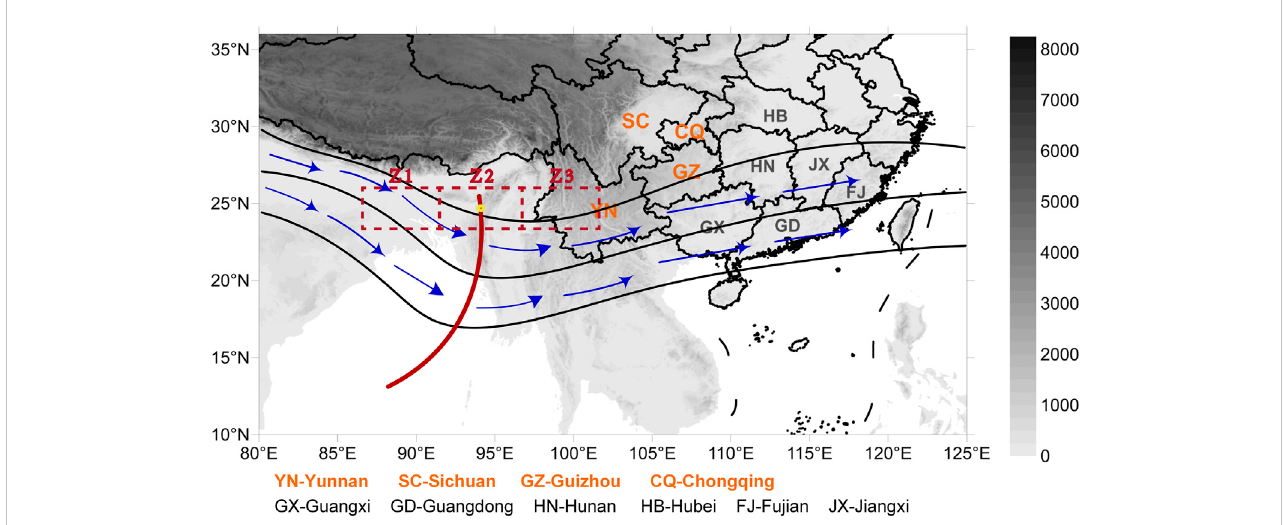
FIGURE 1 Schematic diagram of the topography and southern branch of the westerly winds around the Qinghai – Tibetan Plateau and southern China. The locations of provinces in southwestern (southeastern) China are marked with red (black) acronyms. The digital elevation model of the topography is shown in gray. The black contours and blue vectors show the geopotential height fi eld and the wind fi eld at 700 hPa, respectively. The red solid line shows the trough line of the SBT. The red boxes shown as dashed lines of Z2, Z1, and Z3 represent the trough line region and the regions behind and in front of the SBT in the objective SBT identi fi cation method,